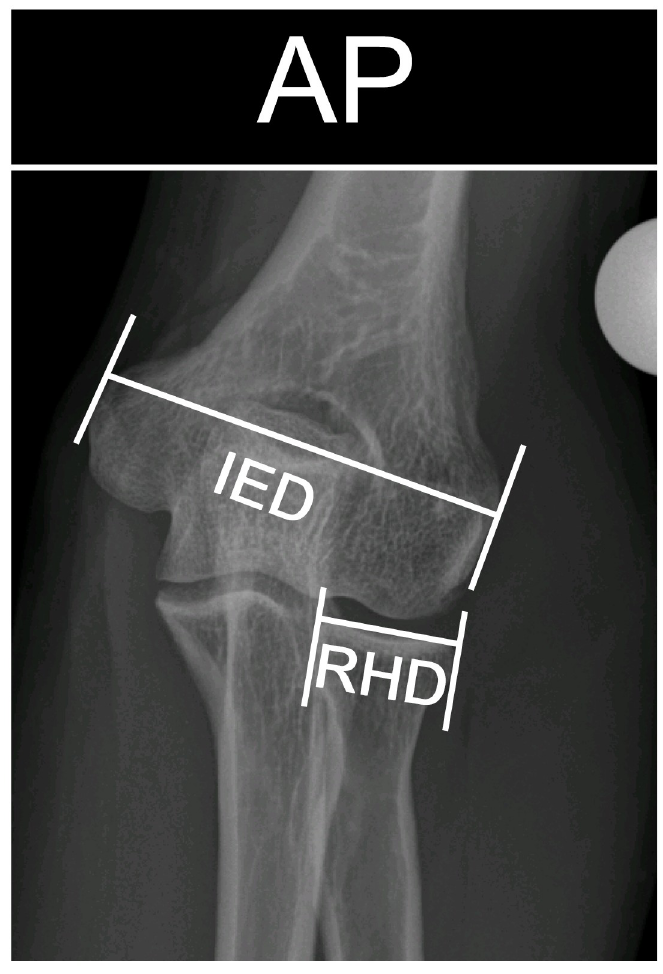
Fig 4. Inter-epicondylar distance (IED) and radial head diameter (RHD). IED = inter-epicondylar distance: Measured from the medial to the lateral epicondyle. RHD = radial head diameter: Measured as the diameter of the radial head, perpendicular to the radial head